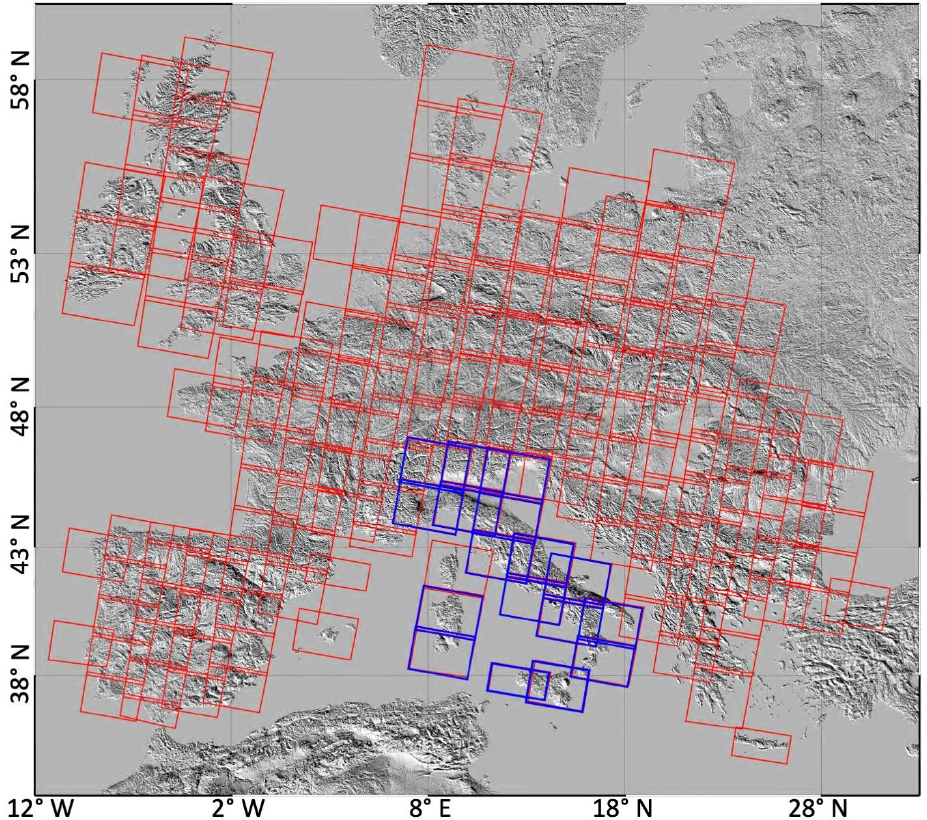
Figure 9. SRTM DEM of the investigated area with the locations of the analyzed S-1 IWS frames. Note